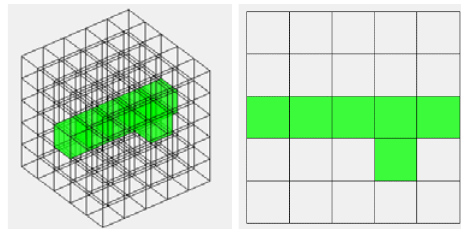
Figure 8. The oblique voxel representation (left image) and the top view (right image) of the imaging geometry in the first test case.